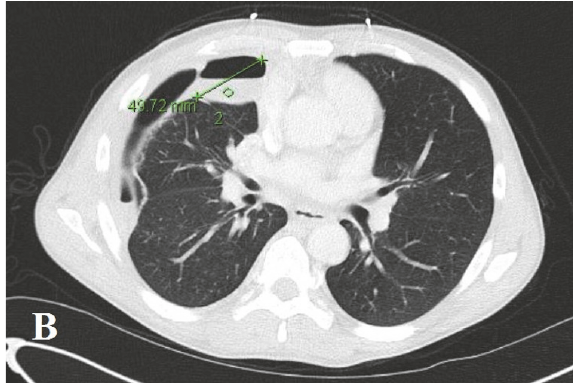
Figure 2: Hydropneumothorax.